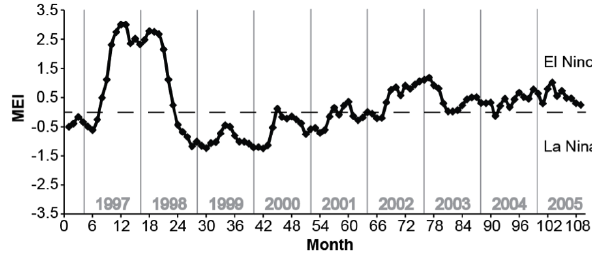
Figure 5. Multivariate ENSO index (MEI) of months included in Stage III NEXRAD gridded products. Months are numbered from September 1996 to September 2005 with years shown in gray. Dashed black line MEI equal to zero. A positive MEI indicates El Niño conditions, while a negative MEI indicates La Niña condi-